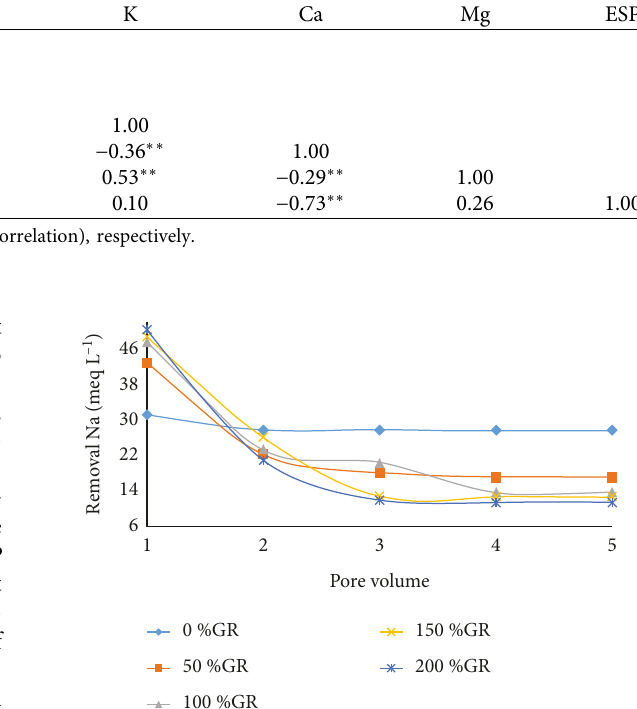
Figure 2: Mean value of cumulative leachate losses of Na at an increasing PG